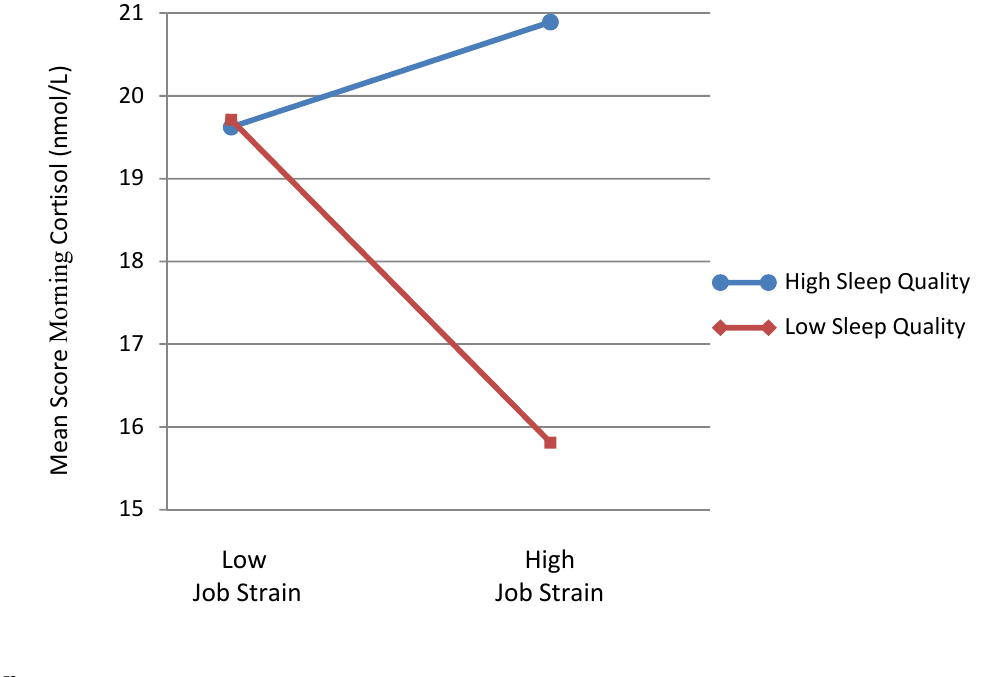
Figure 1. The interaction between job strain and sleep quality on morning saliva cortisol